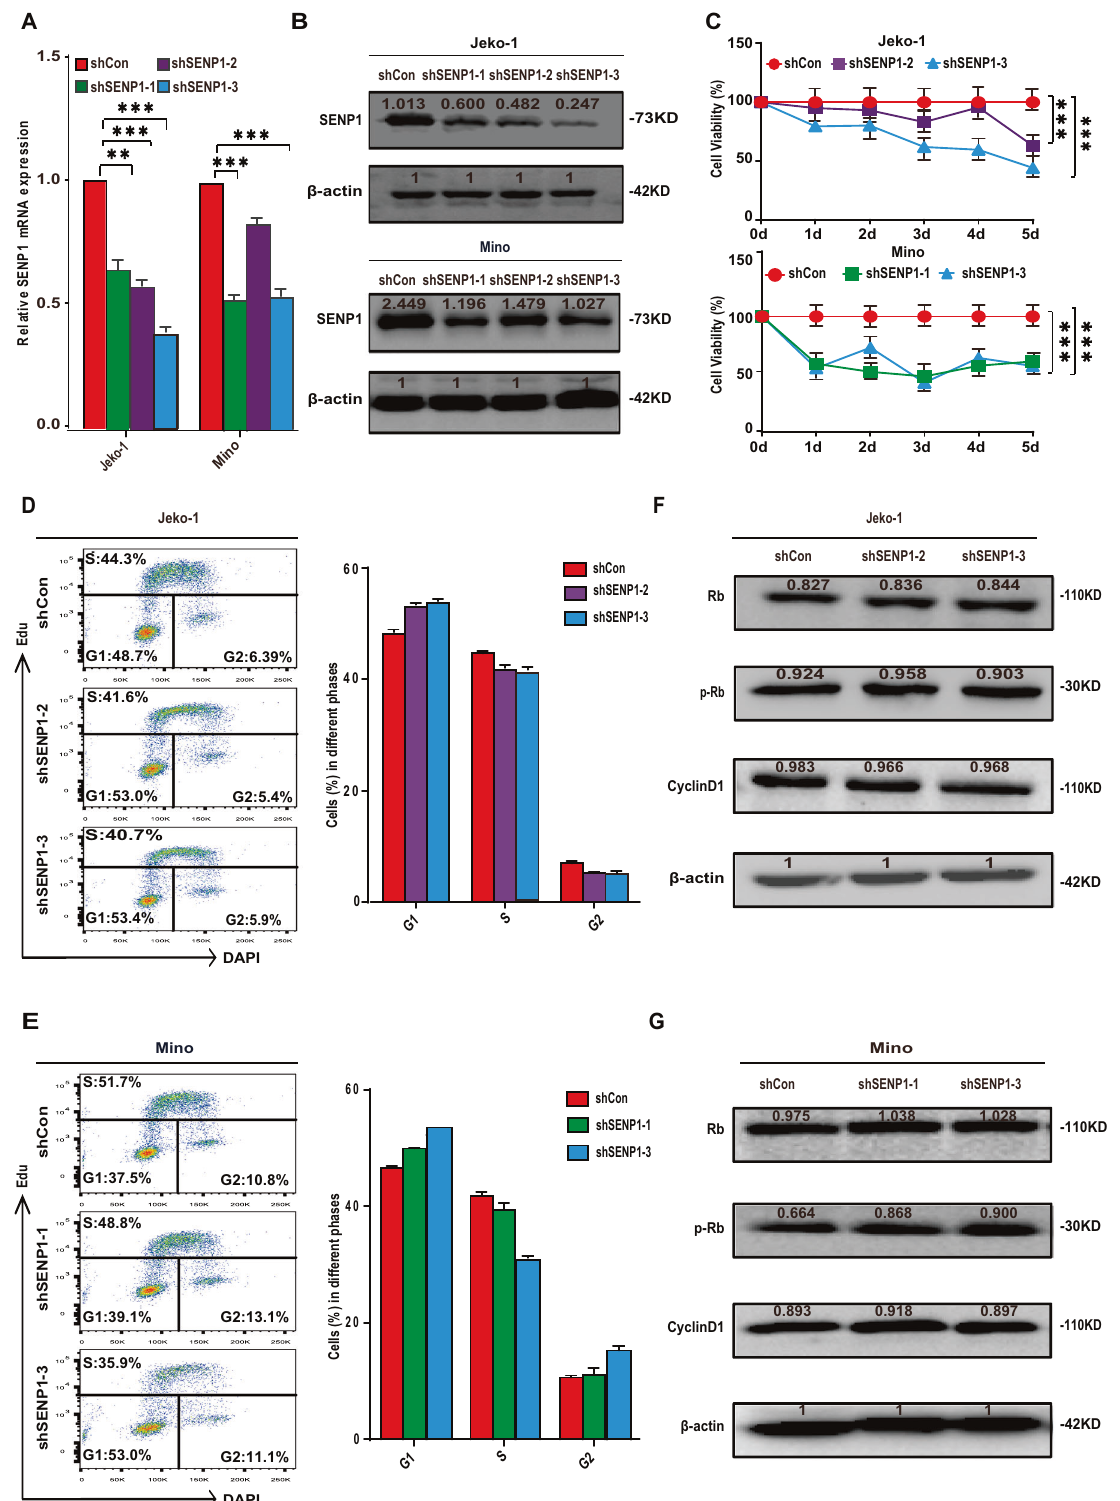
Fig. 2 SENP1 knockdown inhibits proliferation of MCL cells. SENP1 mRNA level was measured by RT-qPCR ( A ), and SENP1 protein level was measured by western blot ( B ) in Jeko-1 and Mino cells after transfected with shSENP1 or shCon. C Cell viability was evaluated by CCK8 array in Jeko-1 and Mino cells after transfected with shSENP1 or shCon. The cell viability of the shSENP1 group was normalized with the value from the shCon group. The cell cycle distribution of the transfected Jeko-1 ( D ) and Mino ( E ) cells was assessed by Edu and DAPI staining and fl ow cytometric analysis. The proportion of cells in G1, S, and G2 phases was shown in the right histogram. The Rb, p-Rb and CyclinD1 protein levels were measured by western blot in the transfected Jeko-1 ( F ) and Mino ( G ) cells. Data were presented as mean ± SD and analyzed by two-sided Student ’ s t test. n = 3; ** P < 0.01, and *** P < 0.001.